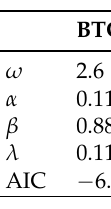
Table 3. GARCH(1,1) calibrated